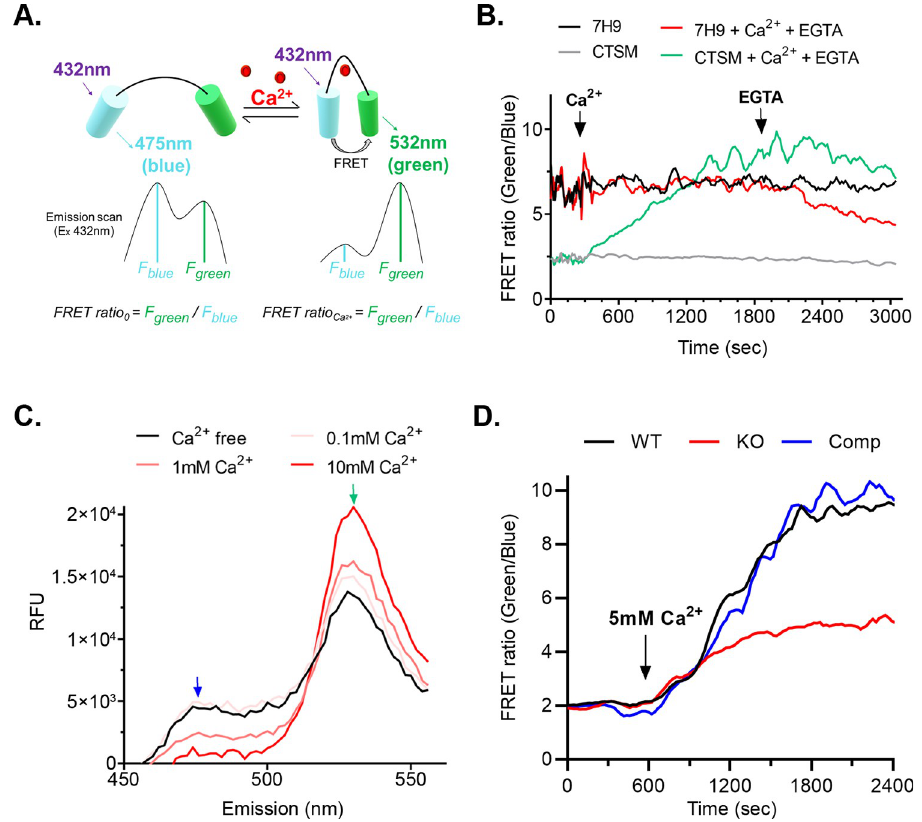
Fig 4. PE15/PPE20 facilitate Ca 2+ uptake. (A) Schematic of the Ca 2+ FRET probe and its ratiometric signal. (B) Ca 2+ FRET signals in different media show that Ca 2+ presents in standard 7H9 compromise Ca 2+ detection. FRET ratio was calculated by calculating the green:blue fluorescence ratio and was plotted against time. (C) The FRET probe generates a robust, dose dependent FRET signal. Emission scan of Mtb-twitch incubated with increasing concentrations of Ca 2+ for 30 min at 37˚C. (D) FRET trace over time shows reduced Ca 2+ influx in the pe15 / ppe20 KO strain. The data underlying all the plots in this figure are included in S1 Data. Ca 2+ , calcium ion; FRET, fluorescence resonance energy transfer; KO, knockout; WT, wild